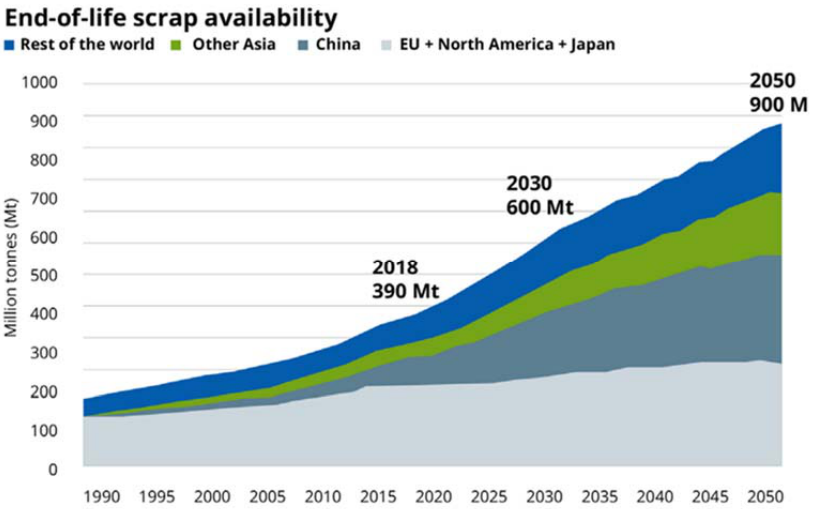
Figure 2. End of life scrap availability in million tons per year (MTPA). Reprinted with a permission from ref. [4].